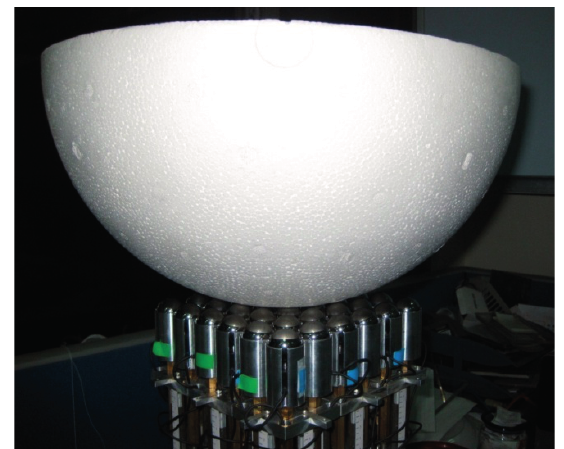
Figure 7. Setup for shape setting/tracing test.